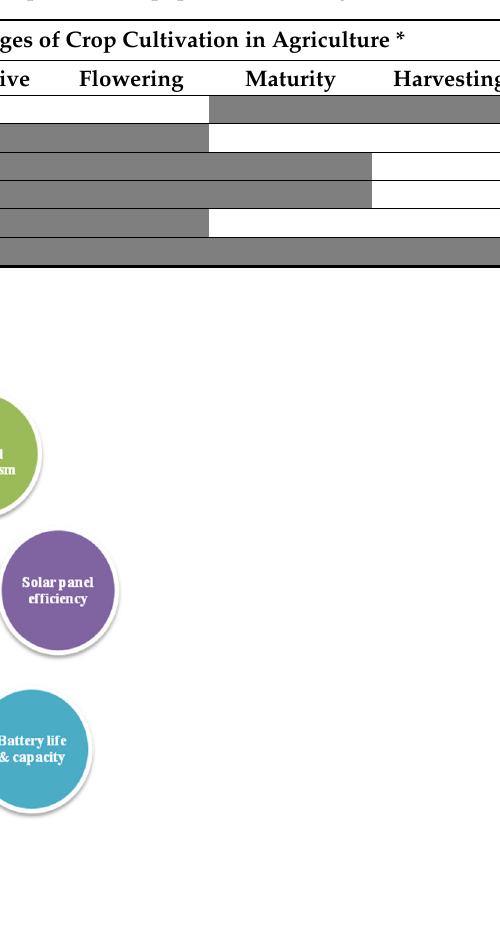
Table 7. Schedule of different PV-powered plant protection equipment used in agriculture.